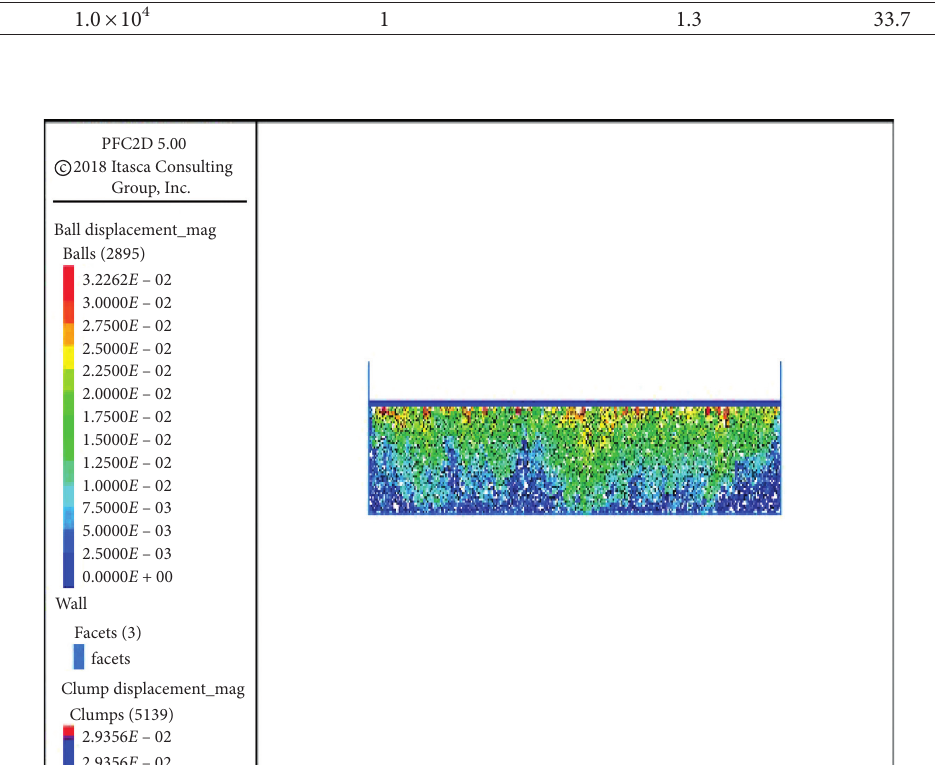
Figure 9: Discrete element particle migration map of 30cm thick reclaimed soil with one